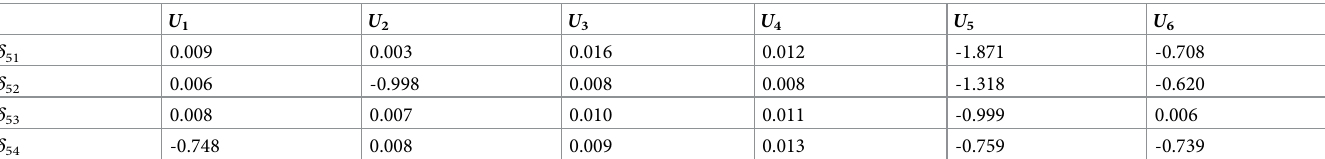
Table 23. The relative dominance of O 5 to others.